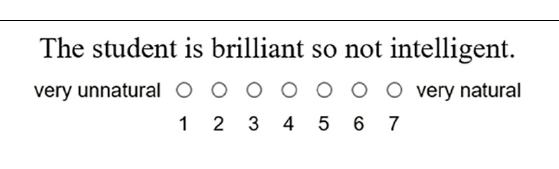
FIGURE 5 | Sample item in Experiment